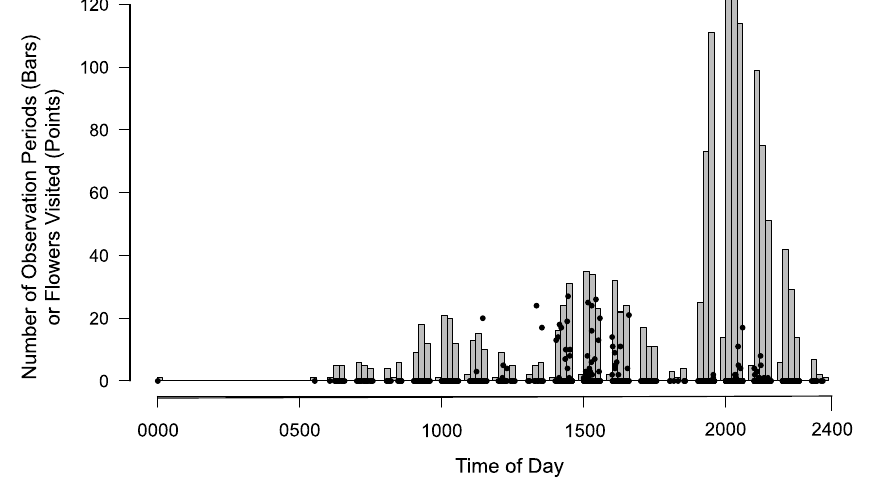
F IGURE 2. Sampling effort and temporal patterns of flower visitation to Abronia umbellata var. umbellata flowers in natural populations. Bars represent the number of pollinator observation periods conducted at a given time and points represent the total number of flowers visited during an observation period at a given time. Data is pooled across days and